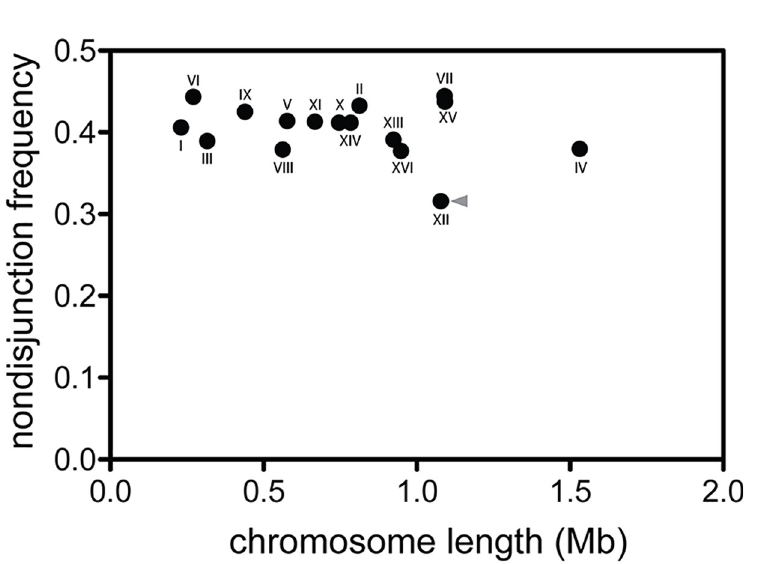
Fig 2. An interspecific cross between S . cerevisiae and S . paradoxus exhibits extremely high rates of meiosis I nondisjunction. Black circles represent the nondisjunction rate for each of 16 homologous chromosome pairs. Underlying data can be found in S1 Data. Random segregation would correspond to a nondisjunction frequency of 0.5, while perfect segregation would correspond to a nondisjunction frequency of 0.0. Chromosome lengths represent the total amount of alignable sequence per chromosome pair between the genomes of the two species. Length estimates were obtained using the complete genomes of S . cerevisiae strain SK1 (instead of Y55) and S . paradoxus strain CBS432 (instead of N17) because these are the most closely related strains for which end-to-end assemblies are available [22]. The alignable regions of these two genomes are 87.8% identical (9,784,711 out of 11,146,833 sites). The length of Chr XII (indicated by the grey arrowhead) omits the tandem rDNA repeats, which could not be assembled; the true size of Chr XII may be twice as long as presented. Chr, chromosome; rDNA, ribosomal